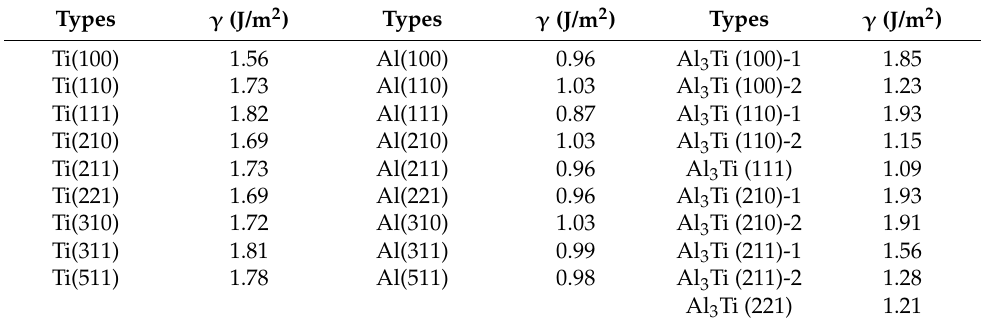
Table 1. The surface energies of various crystal planes for Al, Ti, and Al 3 Ti crystals. Types γ (J/m 2 ) Types γ (J/m 2